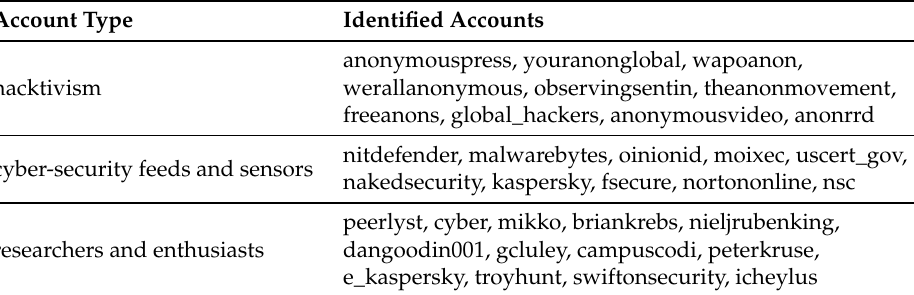
Table 3. Identified Twitter accounts related to hacking and cyber-security.